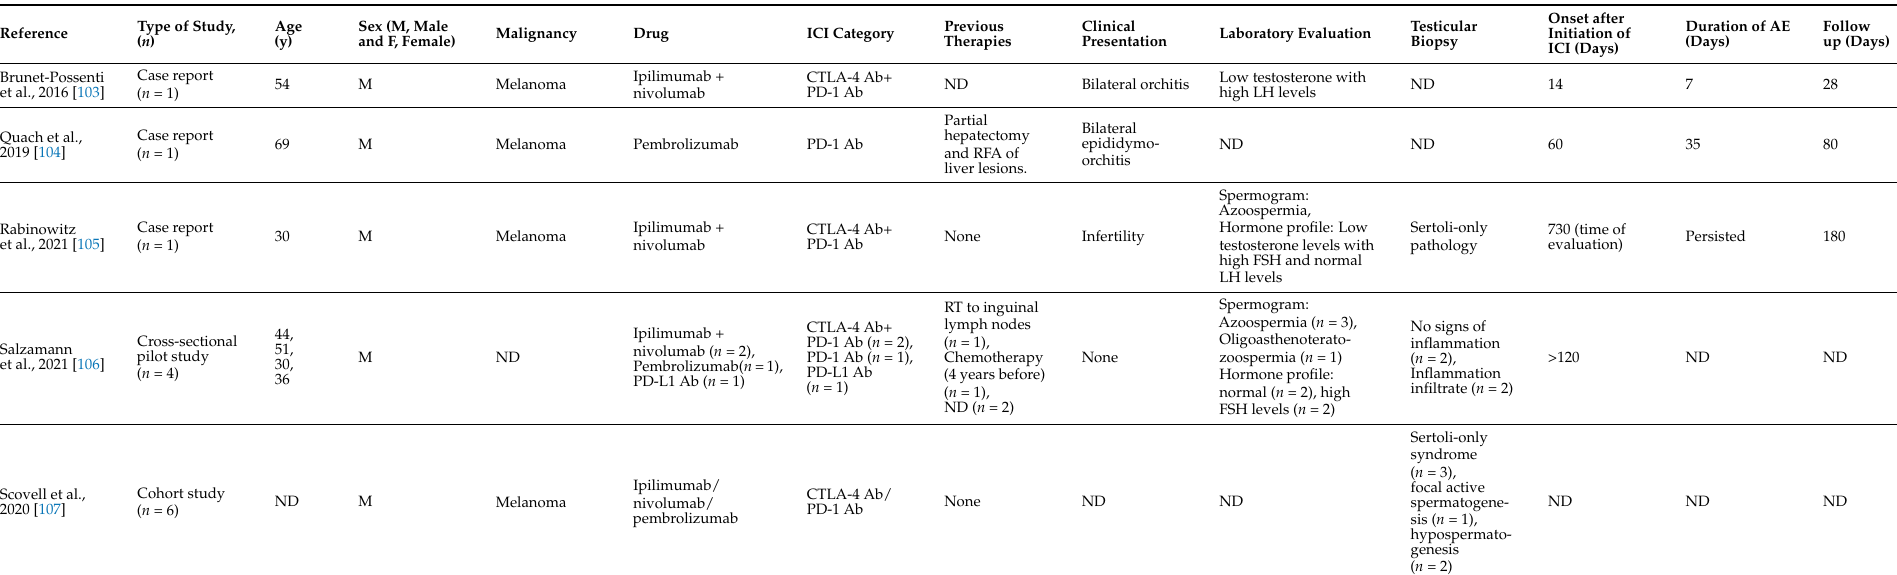
Table 6. Cases in the literature presenting ICI-induced primary (hypergonadotropic) hypogonadism.